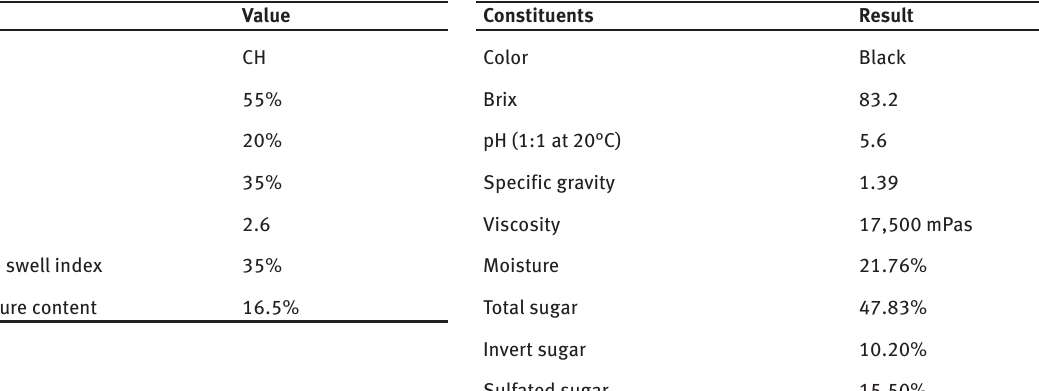
Table 3: Mineral composition of clayey soil.